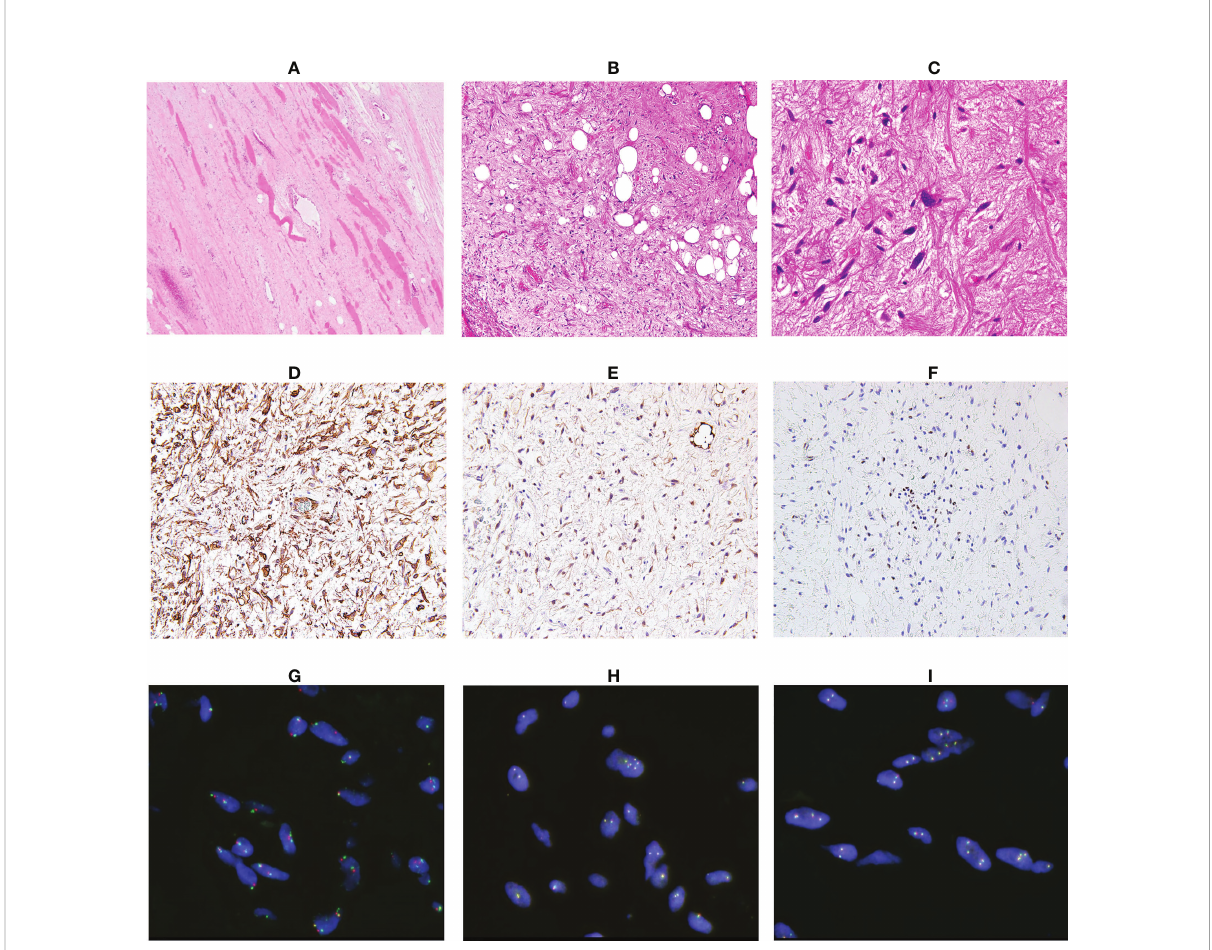
FIGURE 4 Analysis of the resected specimen. The resected specimen showed an ill-de fi ned border ( A , ×100) and a myxoid and fi brous lesion with spindle cells; some spindle cells had cytological atypia ( B , ×100 C , ×200). Immunohistochemical results for CD34 (D) , S100 (E) and RB1 (F) (×200). Fluorescence in situ hybridization indicated no ampli fi cation of MDM2 (G) and no rearrangement of FUS (H) or EWSR1 (I) .